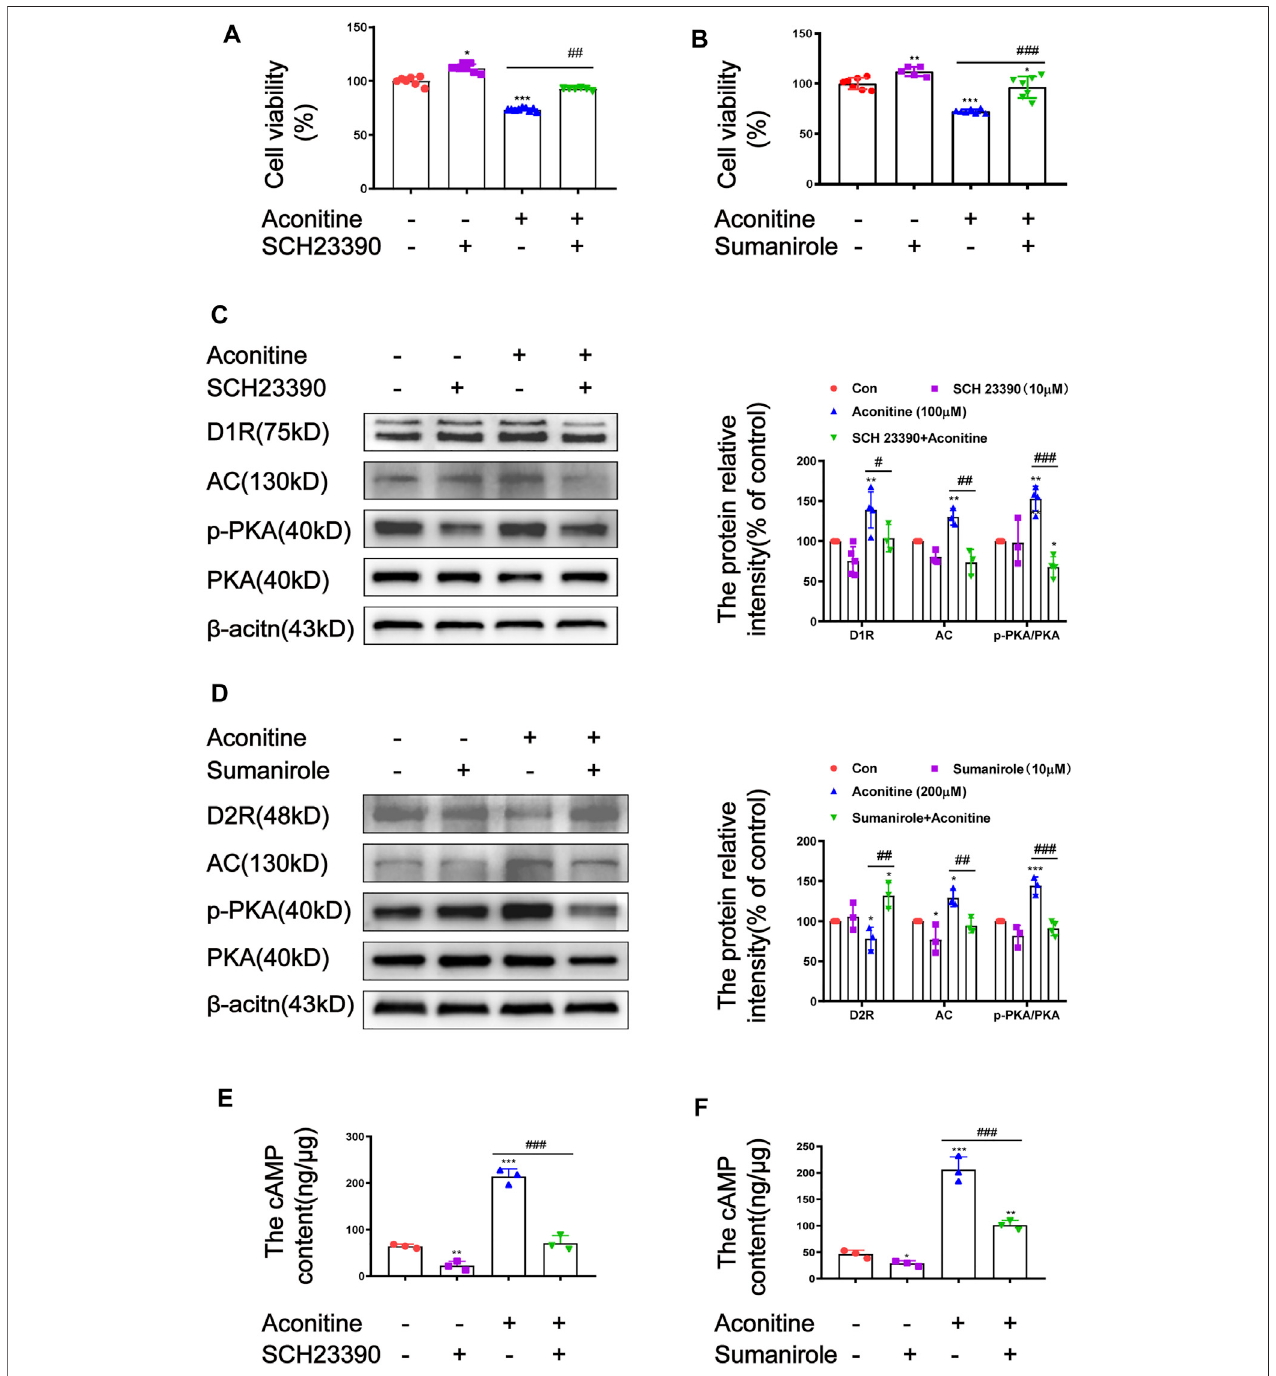
FIGURE 8 | Effects of SCH23390 and sumanirole on aconitine-induced the activation of AC/cAMP/PKA pathway in SH-SY5Y cells. (A – B) SCH23390 and sumanirole inhibited aconitine-induced cytotoxicity in SH-SY5Y cells, respectivevly, n = 9. (C – F) SCH23390 and sumanirole suppressed aconitine-mediated the activationofAC/cAMP/PKApathway, n =5.Thevaluesareexpressedasmean±SD.* p < 0.05,** p < 0.01,*** p < 0.001vs.controlgroups. # p < 0.05, ## p < 0.01, ### p < 0.001 vs. aconitine-treated